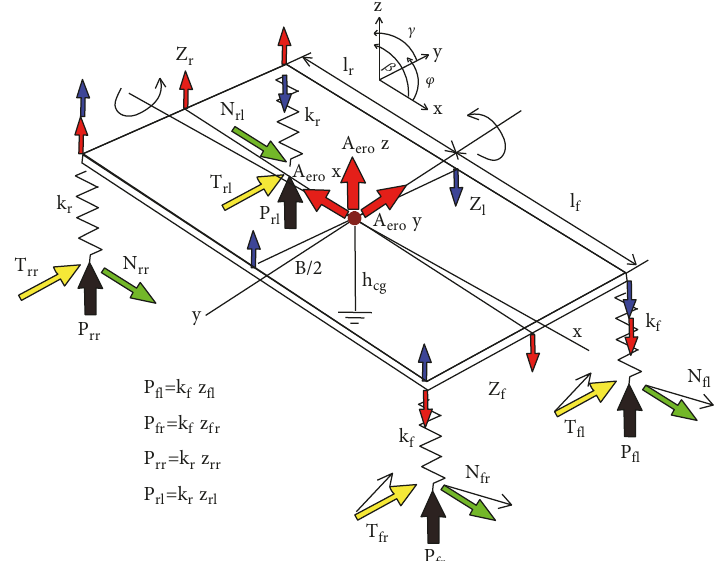
Figure 15: Scheme of forces and body movement definition.